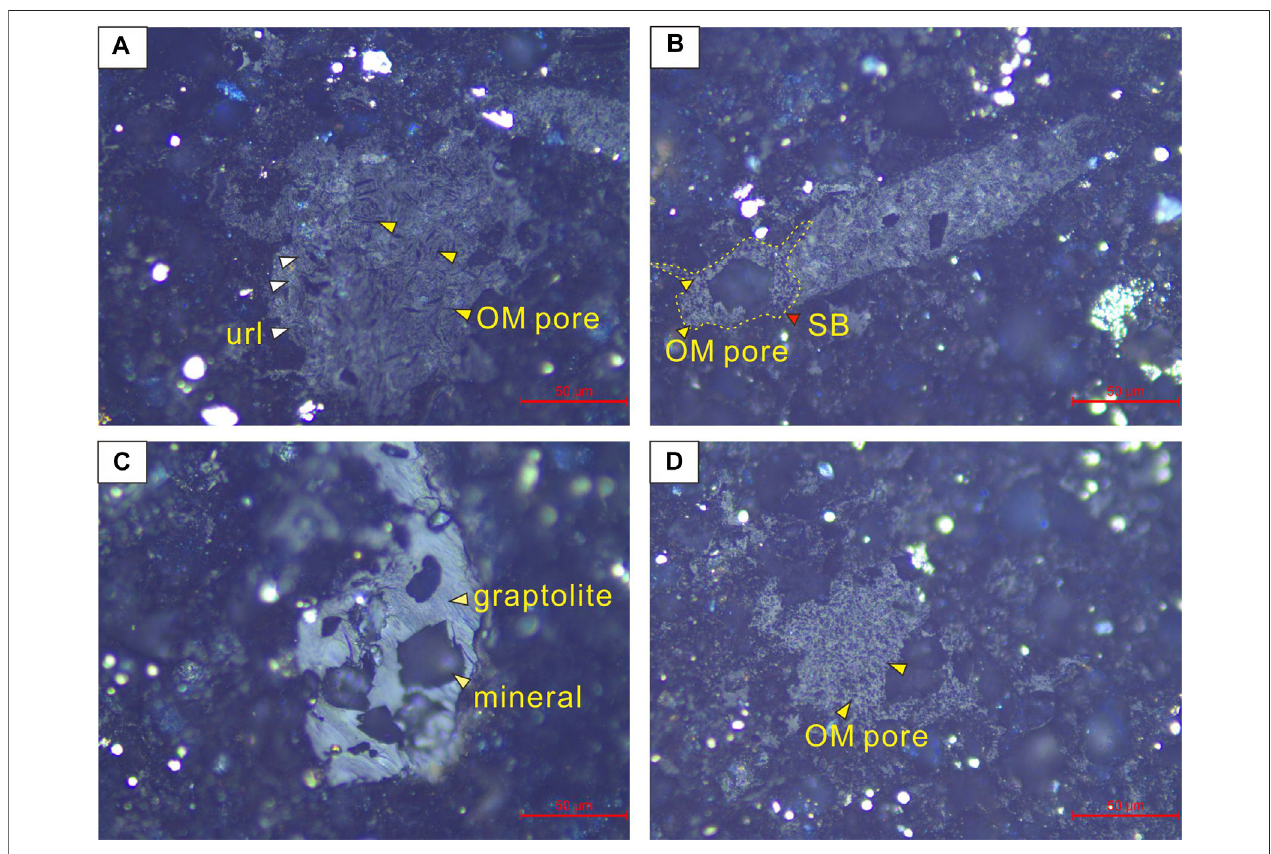
FIGURE 3 | Maceral optics and structure characteristics, argon ion polished section, immersion oil objective. (A) Alginite, with an ultralaminae network structure andlinearOMpores. (B) Alginite,notingthatthealginiteisgraduallyconvertedtosolidbitumen. (C) Graptolite,themineralparticlescutthroughthegraptolitesurface(Hu et al., 2020). (D) Solid bitumen, with homogeneous organic rounded pores. url (cid:2) “ ultralaminae ” ; SB (cid:2) “ solid bitumen ” .